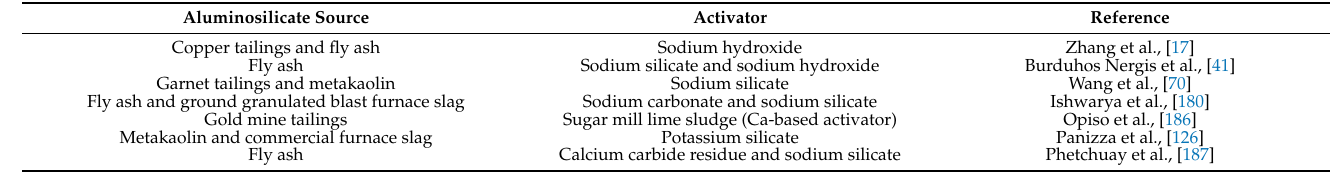
Table 6. Summary of activators used for the formation of